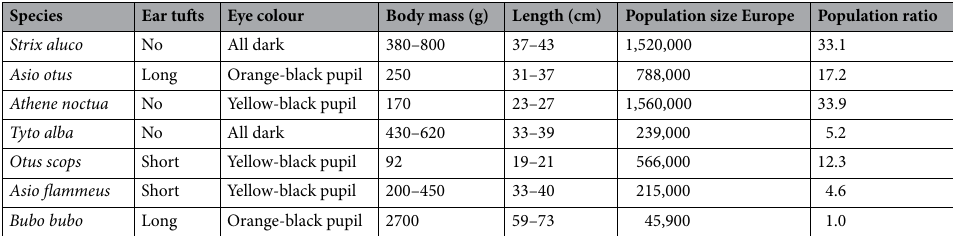
Table 1. Presence/absence of tufts and eye coloration, morphometrics, population size and ratio (in relation to population size of less common species, Bubo bubo ) in Europe, of the owls present in southern Iberia. Body length from Svensson et al. 24 . Population sizes as in IUCN Red List 65